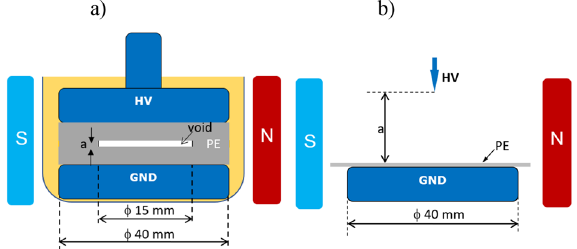
Figure 8. Specimen geometry: ( a ) embedded void in PE; ( b ) corona point-plane